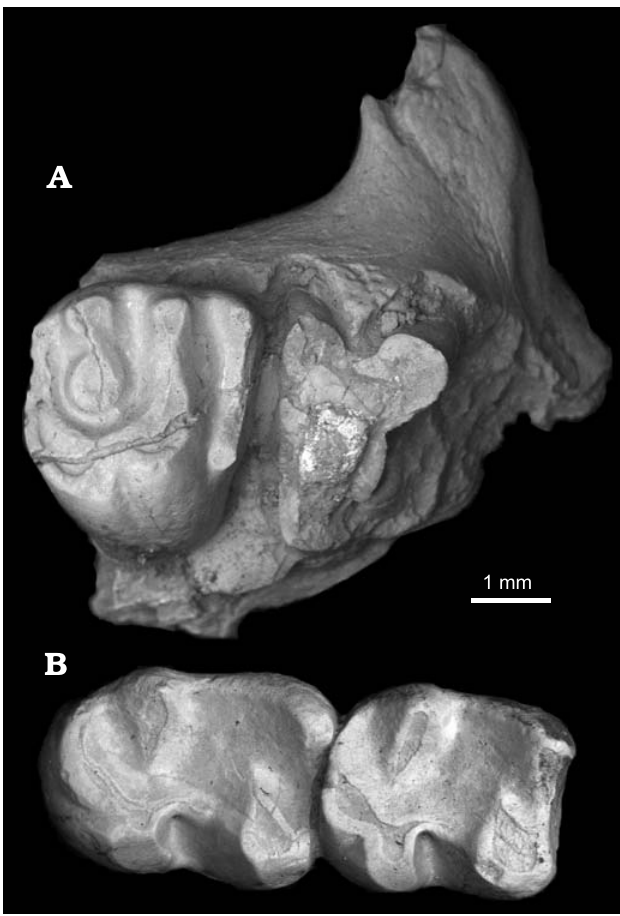
Fig. 14. Ctenodactyloid rodent Yuomys sp. from the Eocene of Wulanhuxiu, Nei Mongol, China. A . Right maxilla with M1 (IVPP V20829.1). B . Right mandible with m2–m3 (IVPP V20829.2). All in occlusal